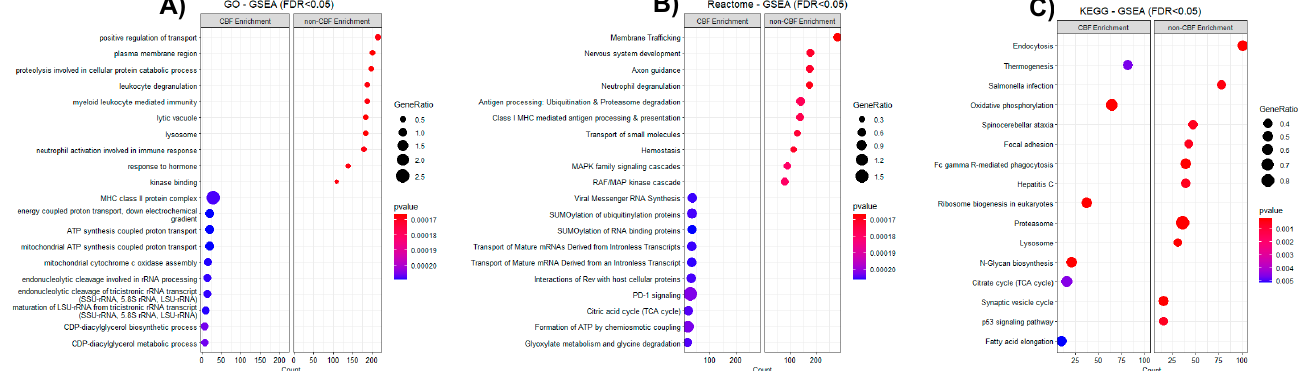
Figure 4. Gene Set Enrichment Analysis (GSEA) of 9800 proteins comparing CBF AML to non-CBF AML. Each dotplot showing the top 10 category enriched pathways ranked by count and FDR in CBF AML (left) or non-CBF AML (right). ‘Count’ is the number of proteins enriched in each term. ‘GeneRatio’ is the percentage of selected proteins count over the set size for a given term. ( A ) GSEA results of all GO terms including Biological Process (BP), Molecular Function (MF), and Cellular Component (CC); ( B ) GSEA results of Reactome terms; ( C ) GSEA results of KEGG terms.